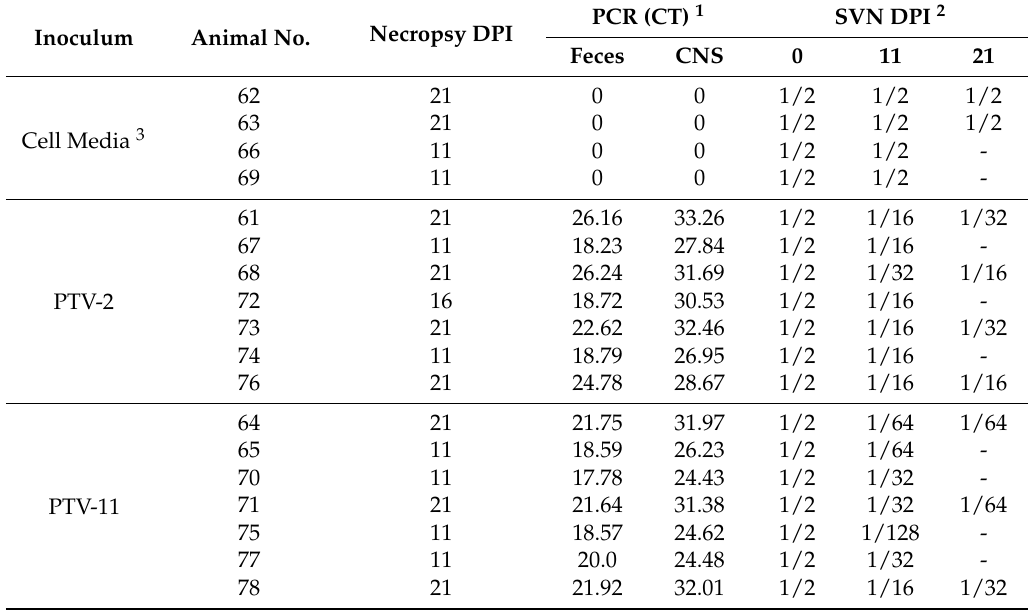
Table 6. Polimerase chain reaction (PCR) and serum virus neutralization test (SVN) results.